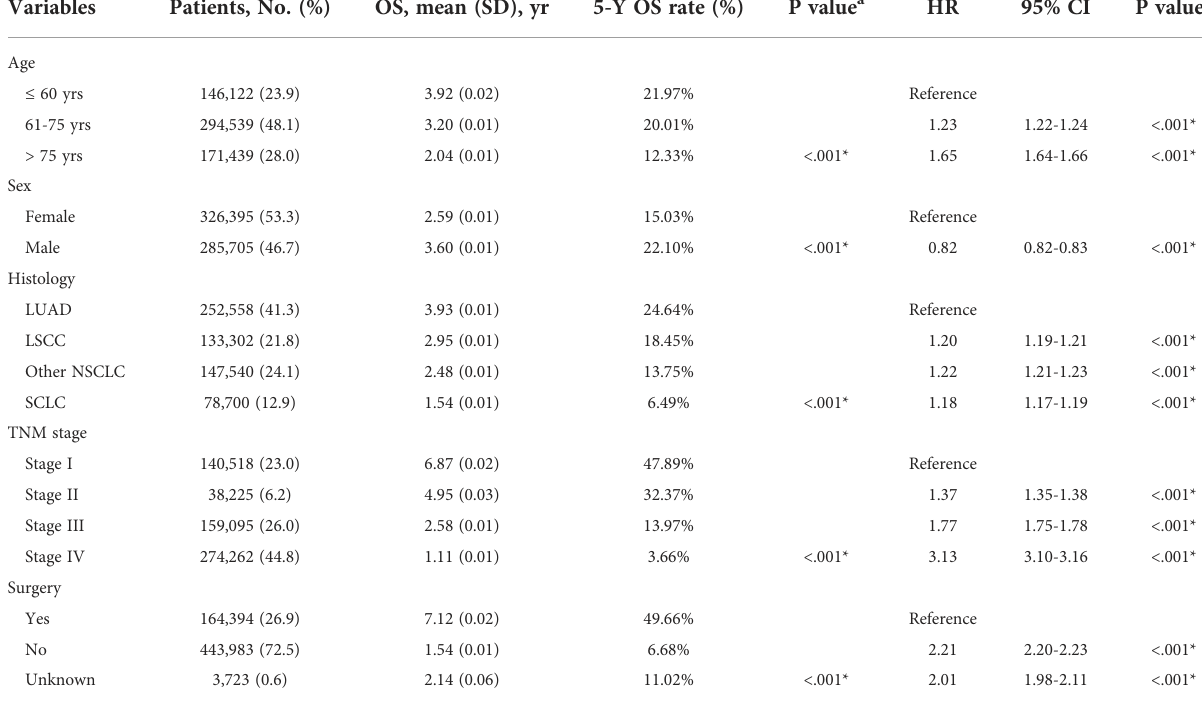
TABLE 1 Clinicopathologic characteristics and overall survival